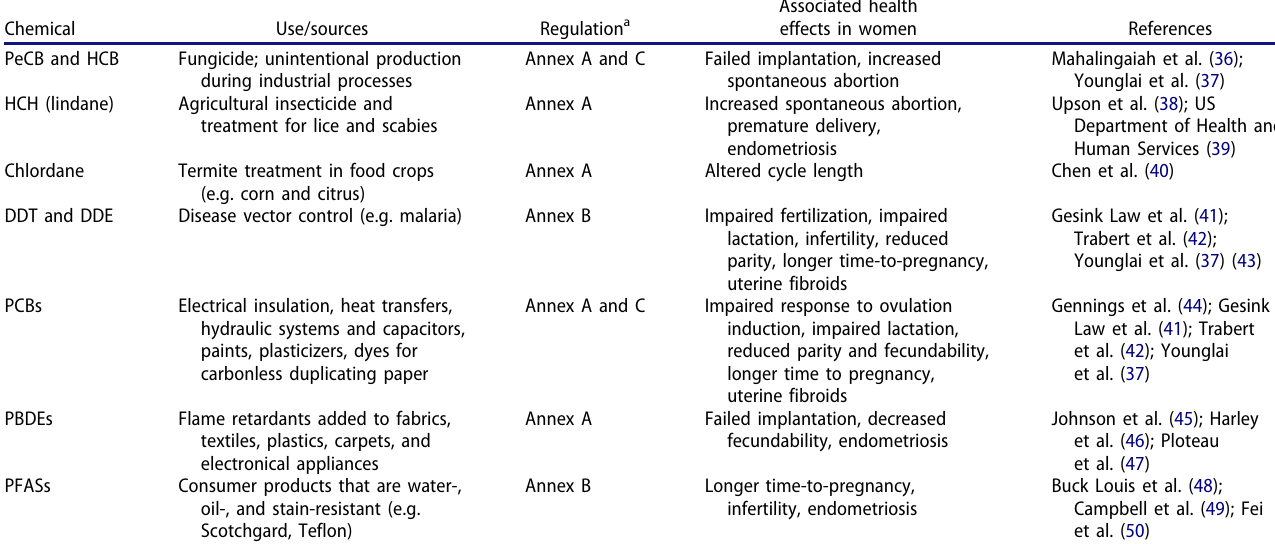
Table 1. Use, source, and regulation of POPs and their suggested reproductive health effects in women.